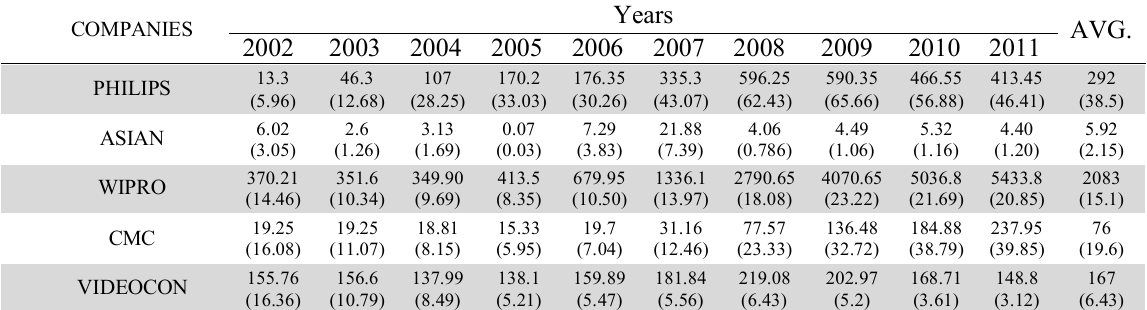
Calculation of Average Cash Holding (Avg. cash holding as percentage of total assets) of Selected Companies of IT